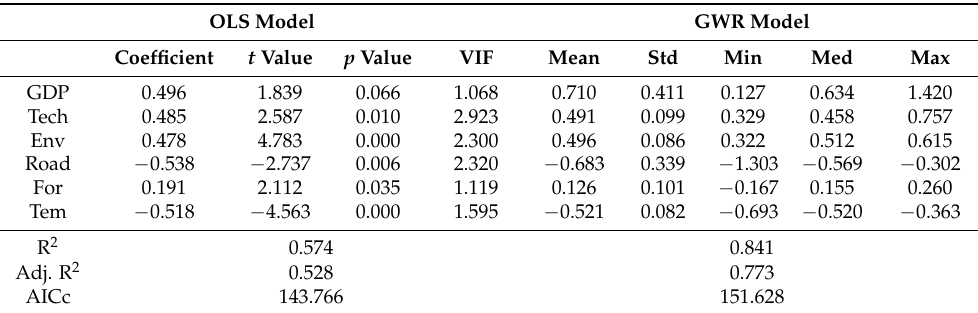
Table 8. Comparison of estimation results between OLS (Ordinary Least Squares) and GWR (Geo- graphically Weighted Regression) models. OLS